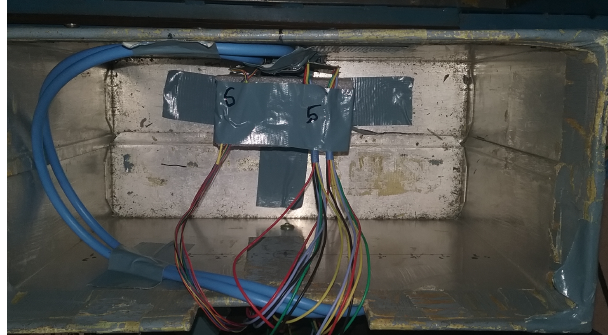
Figure 5. Magnetometers and dosimeters ready to be tested at the GSFC Radiation Effects Facility.